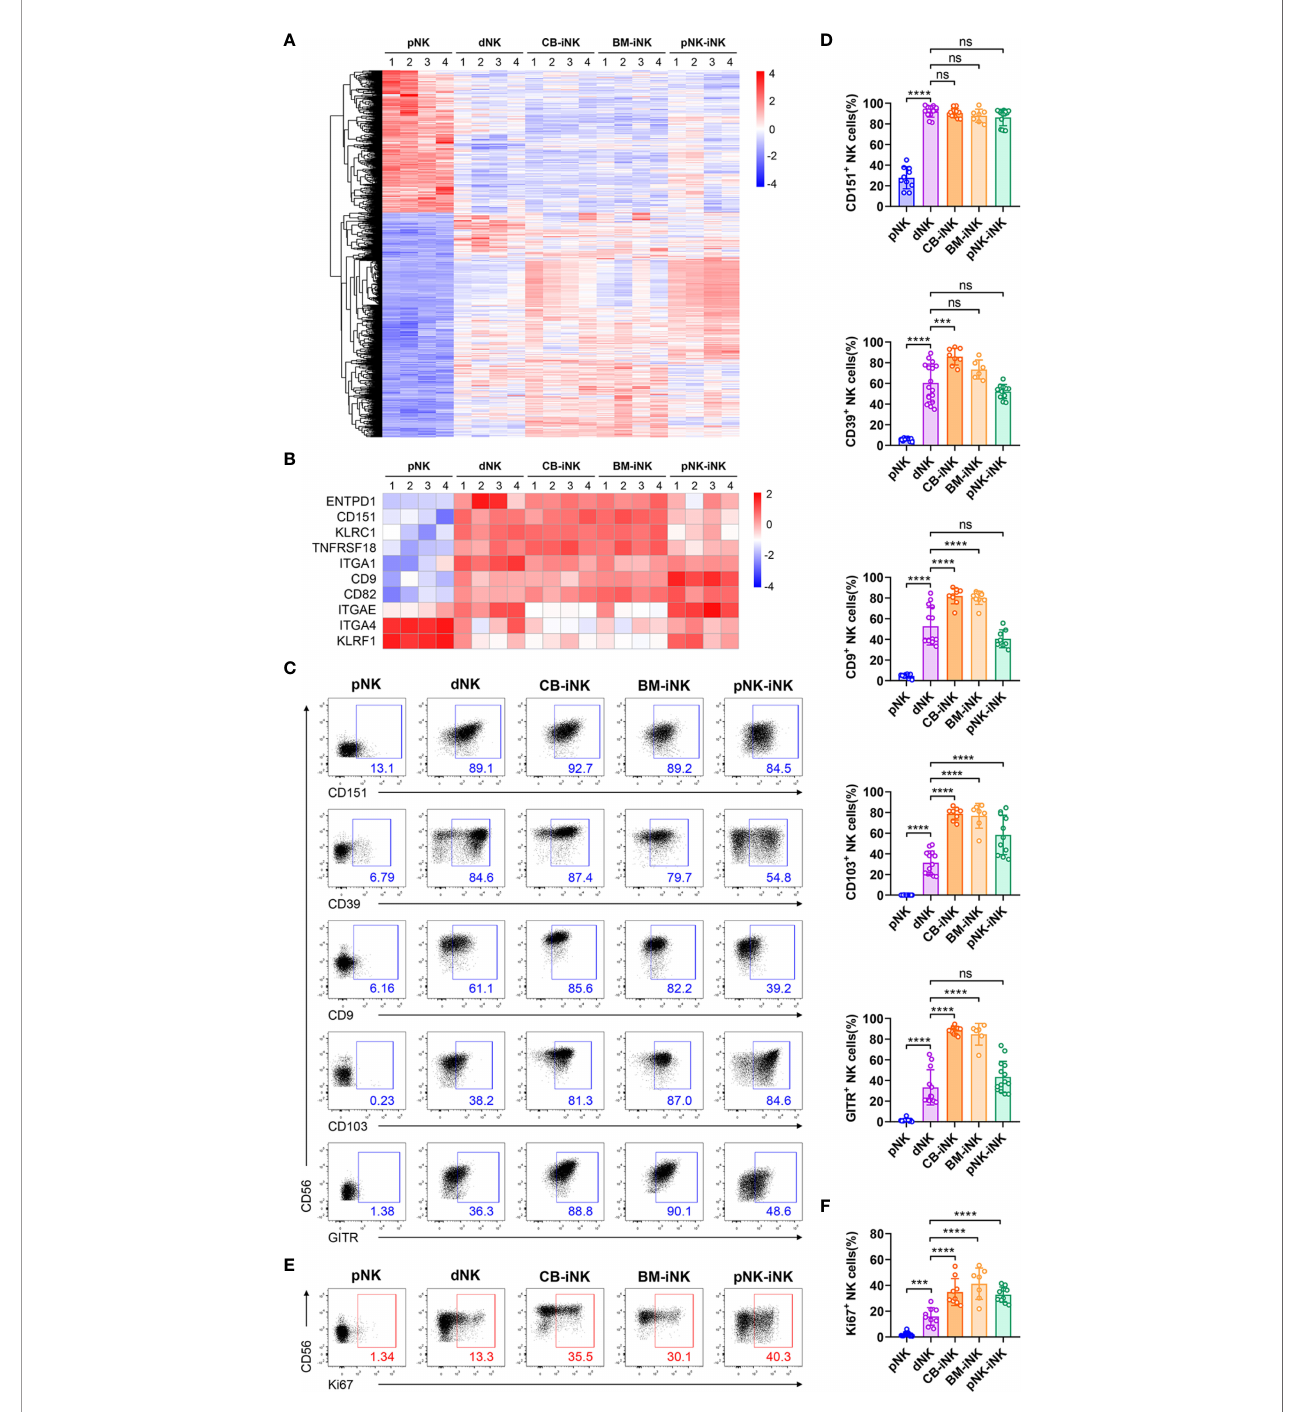
FIGURE 2 | Phenotypic and proliferation potential analyses of iNK cells. (A) The 1116 common differentially expressed genes (DEGs) (fold change > 2 and pvalue < 0.05) of pNK cells compared with other NK cells were selected for heat map analysis. Each column represents one sample (n=4 per group). (B) Some genes encoding phenotypic markers of dNK cells were selected for heat map analysis. Each column represents one sample (n=4 per group). (C, D) The percentage of NK cells that expressed dNK-phenotypic markers and inhibitory receptors in each group was obtained via fl ow cytometry. Representative density plots (C) and statistical calculation of all samples (D) . (E, F) The percentage of NK cells that expressed Ki67 in each group was performed by fl ow cytometry. Representative density plots (E) and statistical calculation of all samples (F) . Data were analyzed by one-way ANOVA. Data represent means± SD, n ≥ 6 in each group. ***p < 0.005; ****p < 0.0001; ns, not signi fi